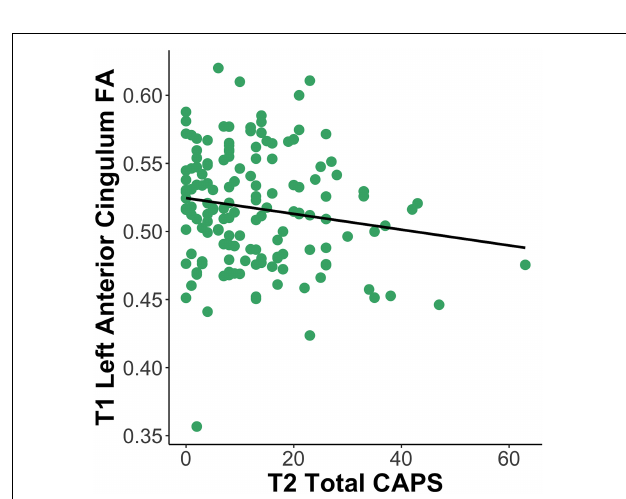
FIGURE 3 | Lesser left anterior cingulum FA at T1 is related to greater total PTSD symptoms at T2 ( β = –48.13, p = 0.003). FA, fractional anisotropy; CAPS, Clinician Administered PTSD Scale; T1, 2-weeks post-trauma; T2, 6-months post-trauma.